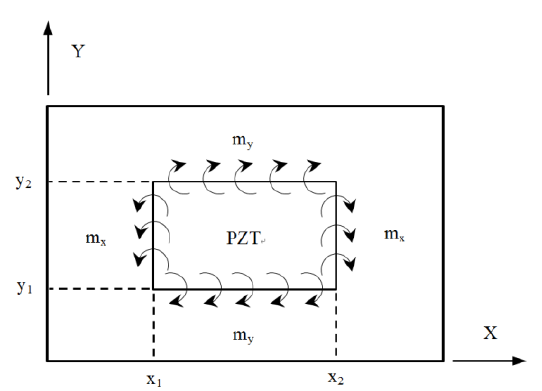
Figure 2. Bending moment exerted on the composite laminate by PZT actuator.